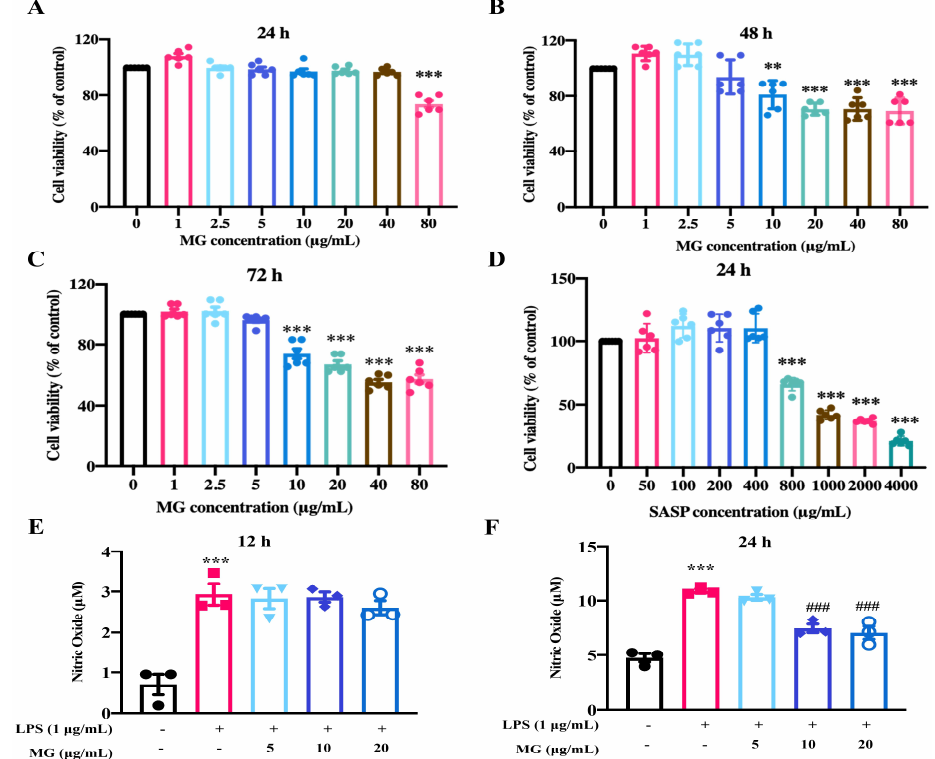
Figure 1. MG alleviates the inflammatory response of LPS−stimulated RAW264.7 cells. ( A − D ) Effects of different concentrations of MG and SASP on the viability of RAW264.7 cells. ( E , F ) Effect of NO production in RAW264.7 cells co−stimulated by MG and LPS for 12 h and 24 h. Data were presented as the means ± SEMs of three independent experiments. ** p < 0.01, and *** p < 0.001 vs. the normal group; ### p < 0.001 vs. the group treated with only LPS.